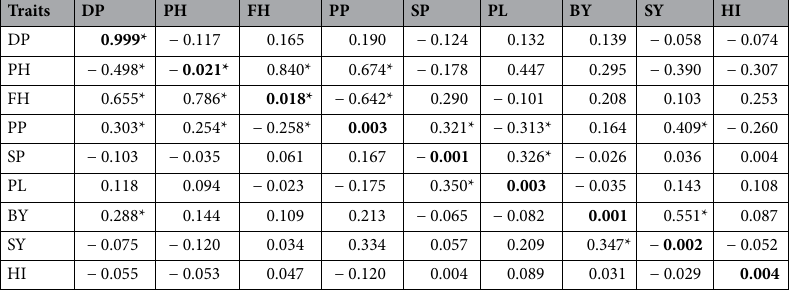
Table 4. Path coefficient showing direct (bold) and indirect effects for agro-morphological traits on days to flowering (DF) in F 3 population advanced from interspecific crosses P. sativum × P. fulvum. DP is days to pod setting, PH is plant height, FH is first pod height, PP is number of pods per plant, SP is number of seeds per plant, PL is pod length, BY is biological yield, SY is seed yield, HI is harvest index. * Indicates significant relationships at P < 0.05.